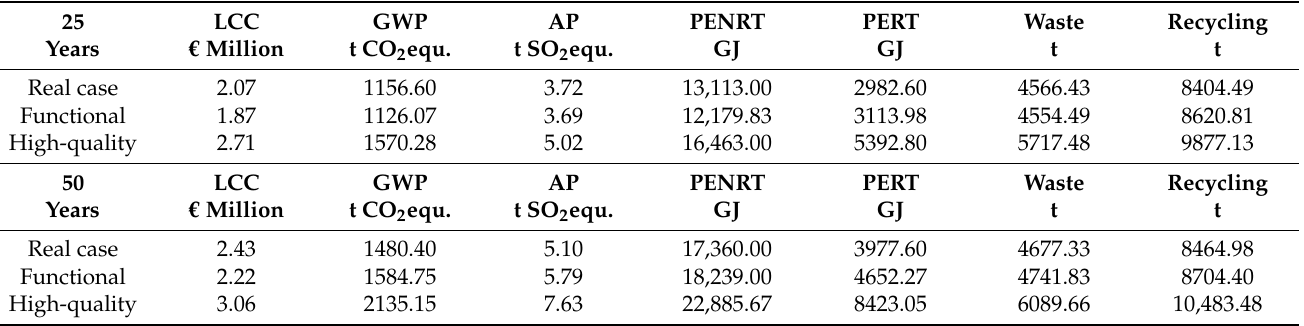
Table 5. LCC, LCA and recycling potential assessment results of the examined enclosure construction variants for the time scenarios 25 and 50